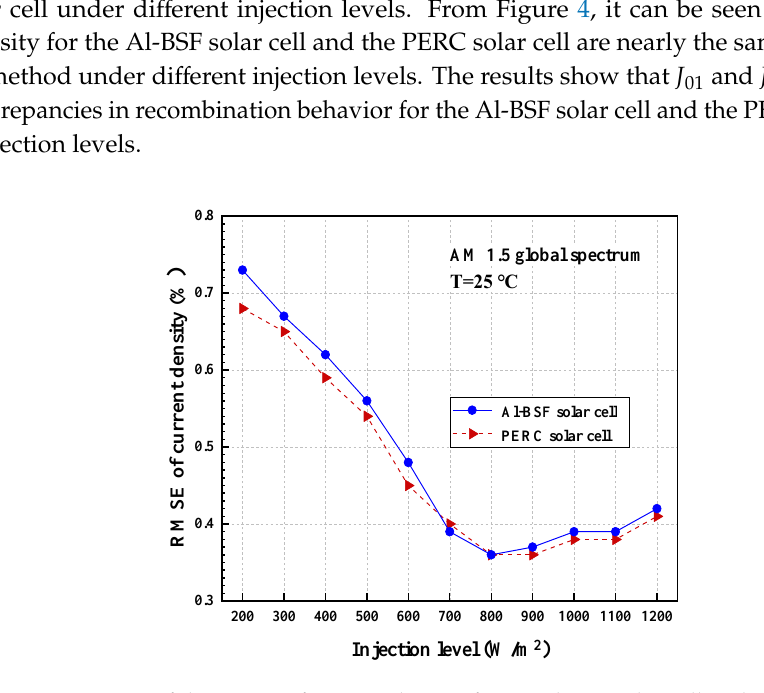
Figure 4. Comparison of the RMSE of current density for an Al-BSF solar cell and a PERC solar cell under different injection levels.